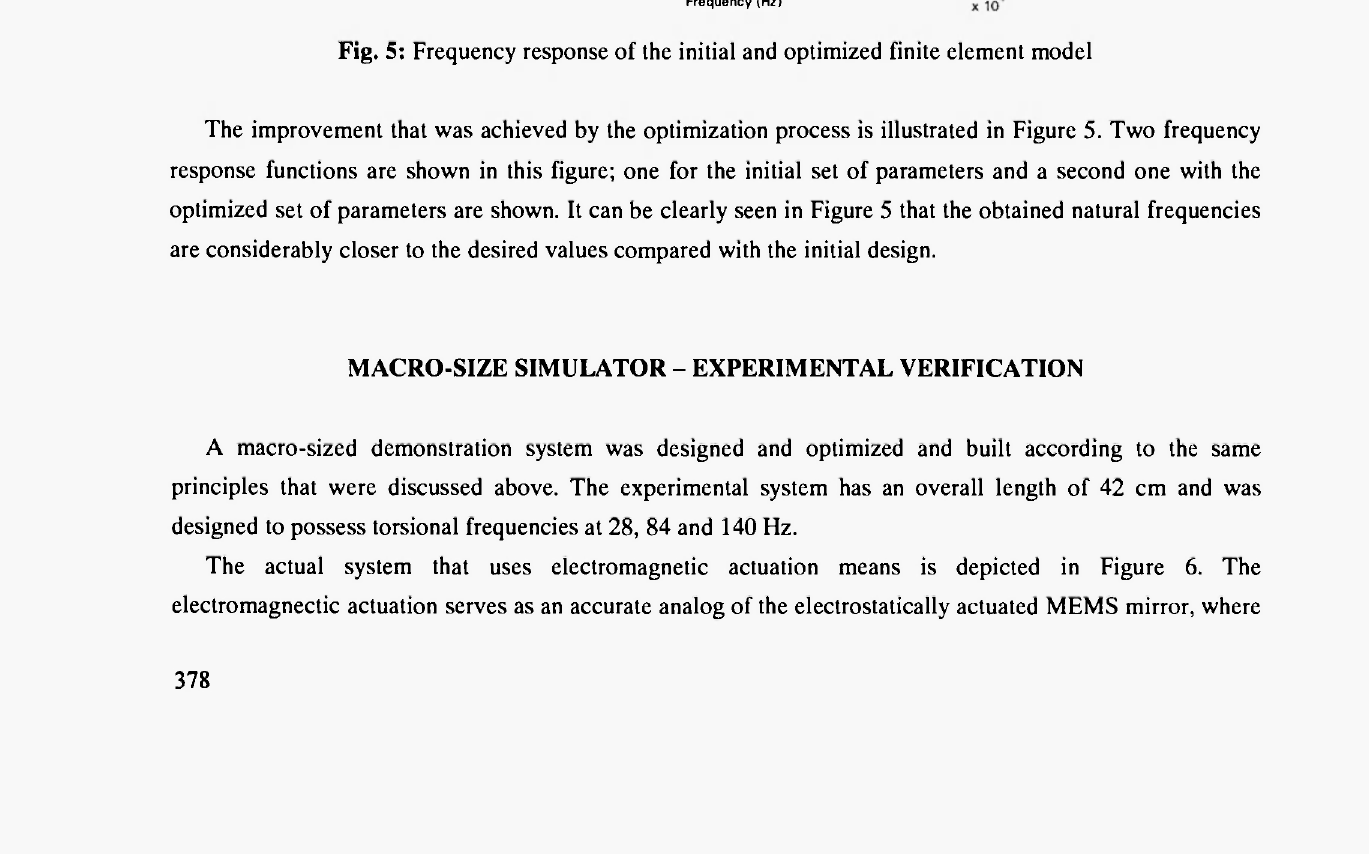
Fig. 5: Frequency response of the initial and optimized finite element